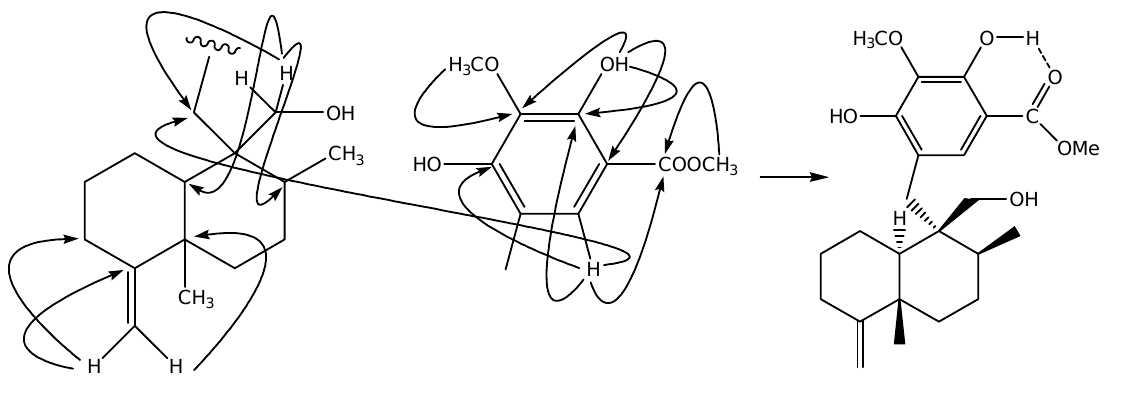
Figure 2. The key HMBC correlations of compound 1.